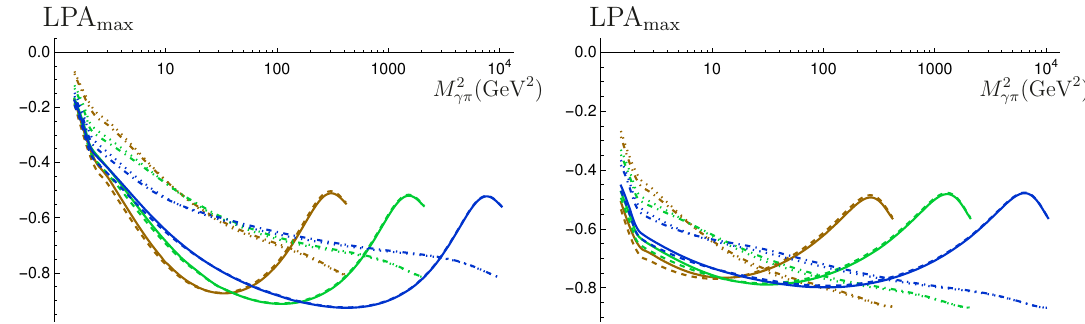
on the γπ = 800 , 4000 and 20000 GeV 2 . The γN